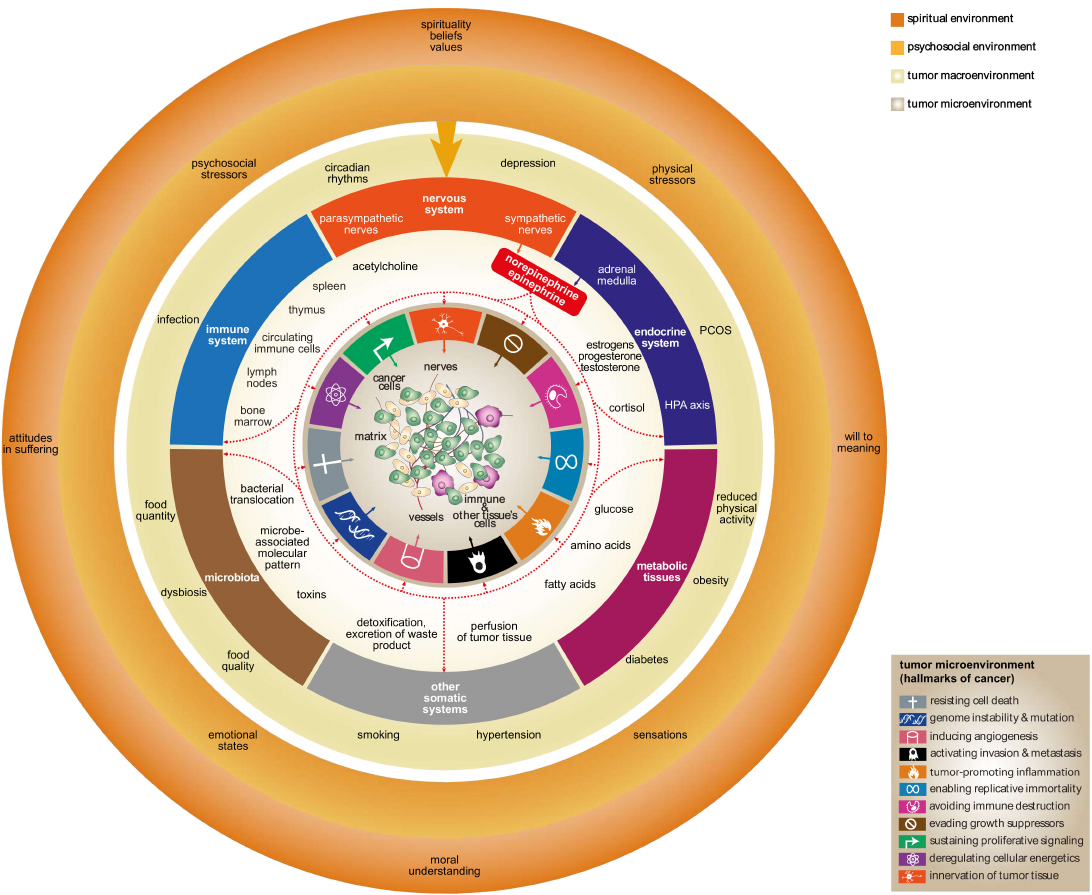
Figure 1. β -adrenergic signaling mediates the e ff ect of the brain on the tumor micro- and macroenvironments (highlighted by red arrows). In addition, β -adrenergic signaling also mediates the e ff ect of psychosocial and noetic environments on cancer development and progression. β -adrenergic signaling a ff ects several components of the tumor macroenvironment, i.e., endocrine, immune, and other somatic systems, including metabolism-related tissues. It a ff ects microbiota as well. Somatic systems, forming the tumor macroenvironment and microbiota, consist of physiological processes, various diseases, and pathological conditions such as circadian rhythms, depression, infection, diabetes, obesity, and hypertension. β -adrenergic signaling directly a ff ects the tumor microenvironment via norepinephrine released by sympathetic nerves innervating tumor tissue and via catecholamines released by the adrenal medulla. Note that in addition to the ten hallmarks of cancer defined by Hanahan and Weinberg [11], tumor innervation was added to the scheme as a new, eleventh hallmark. HPA axis—hypothalamic–pituitary–adrenal axis; PCOS—polycystic ovary